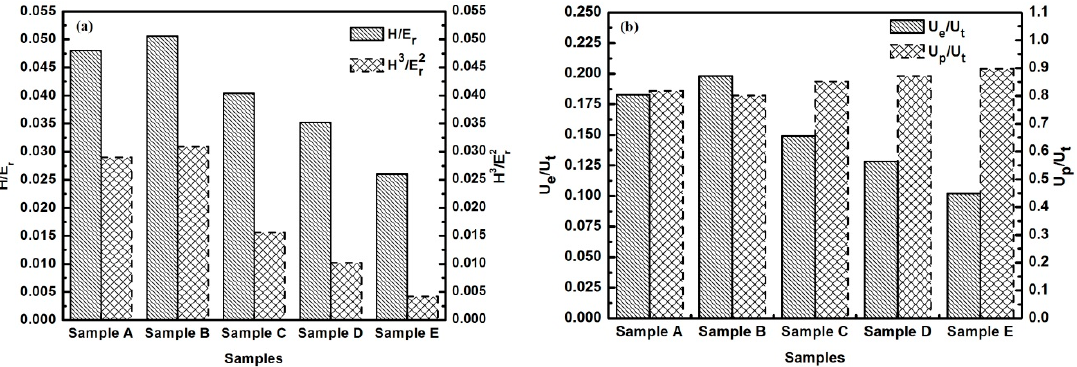
Figure 7. ( a )The 𝐻/𝐸 (cid:3045) and 𝐻 (cid:2871) /𝐸 (cid:3045)(cid:2870) ratios of different printed samples; ( b ) The elastic recovery 𝑈 (cid:3032) /𝑈 (cid:3047) and plasticity index 𝑈 (cid:3043) /𝑈 (cid:3047) of different printed samples.